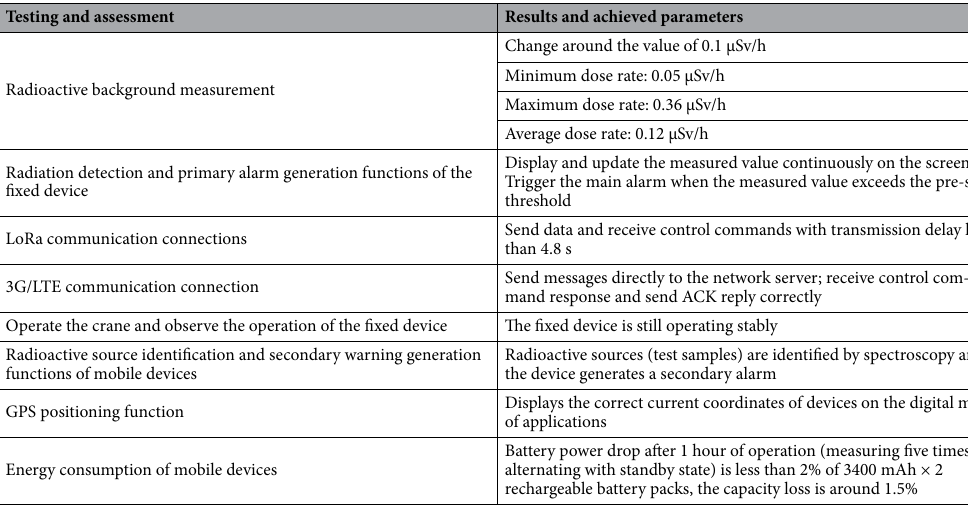
Table 1. List of test contents and achieved results of the IoRSS